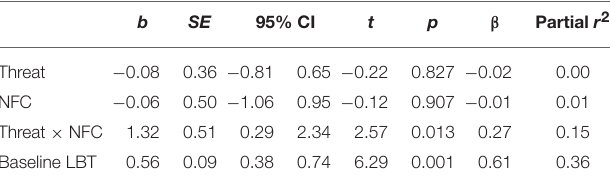
TABLE 2 | Regression statistics for the prediction of post-threat LBT bisection error.